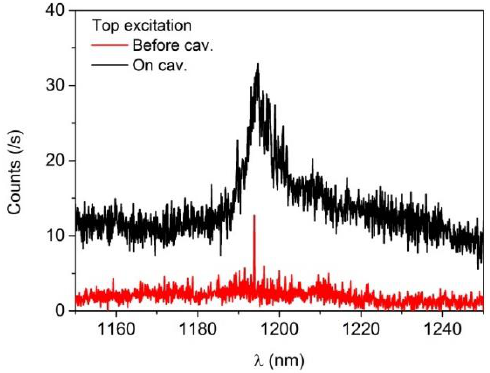
Figure 10. PL spectra on two different excitation position following the previous color coding. A single QD excitonic line is clearly visible on the red